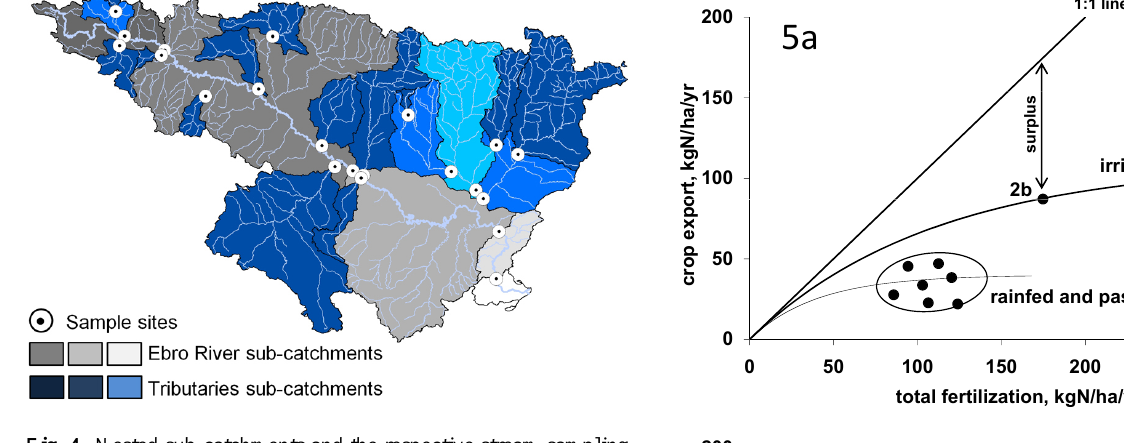
Fig. 4. Nested sub-catchments and the respective stream sampling sites used to estimate pluri-annual N export and detailed N budgets.